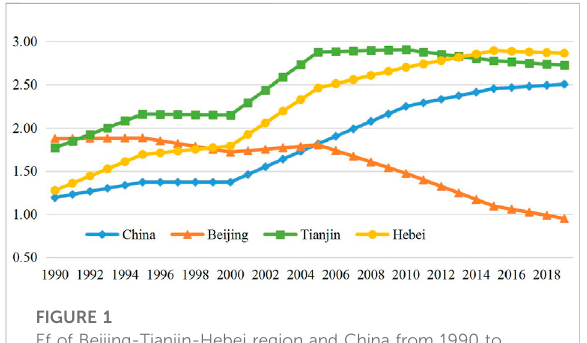
FIGURE 3 Ed of Beijing-Tianjin-Hebei region and China from 1990 to 2019 (Unit: